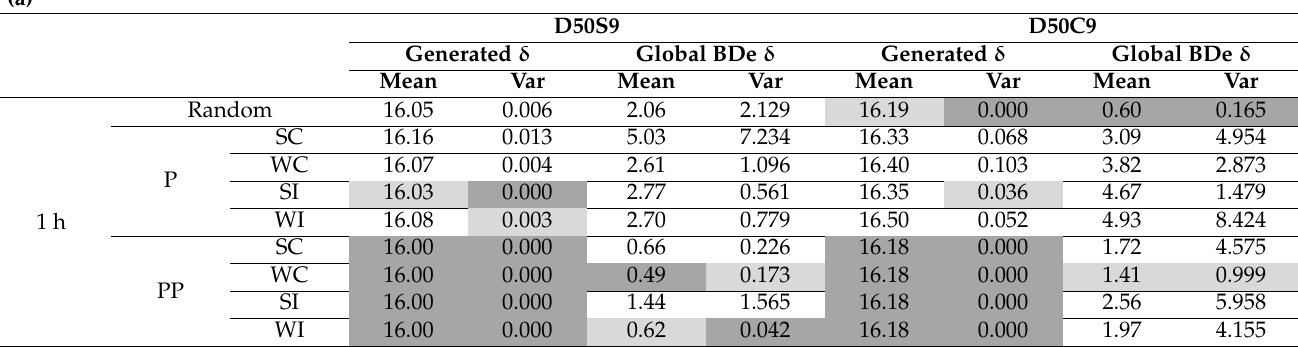
Table 7. Markov blanket distances with the order weight. (a) 50 cases datasets. Dark shaded cells represent the lowest distance or variance in each timed run for the dataset; Bright shaded cells represent the second lowest distance or variance in each timed run for the dataset. (b) 1000 cases datasets. Dark shaded cells represent the lowest distance or variance in each timed run for the dataset; Bright shaded cells represent the second lowest distance or variance in each timed run for the